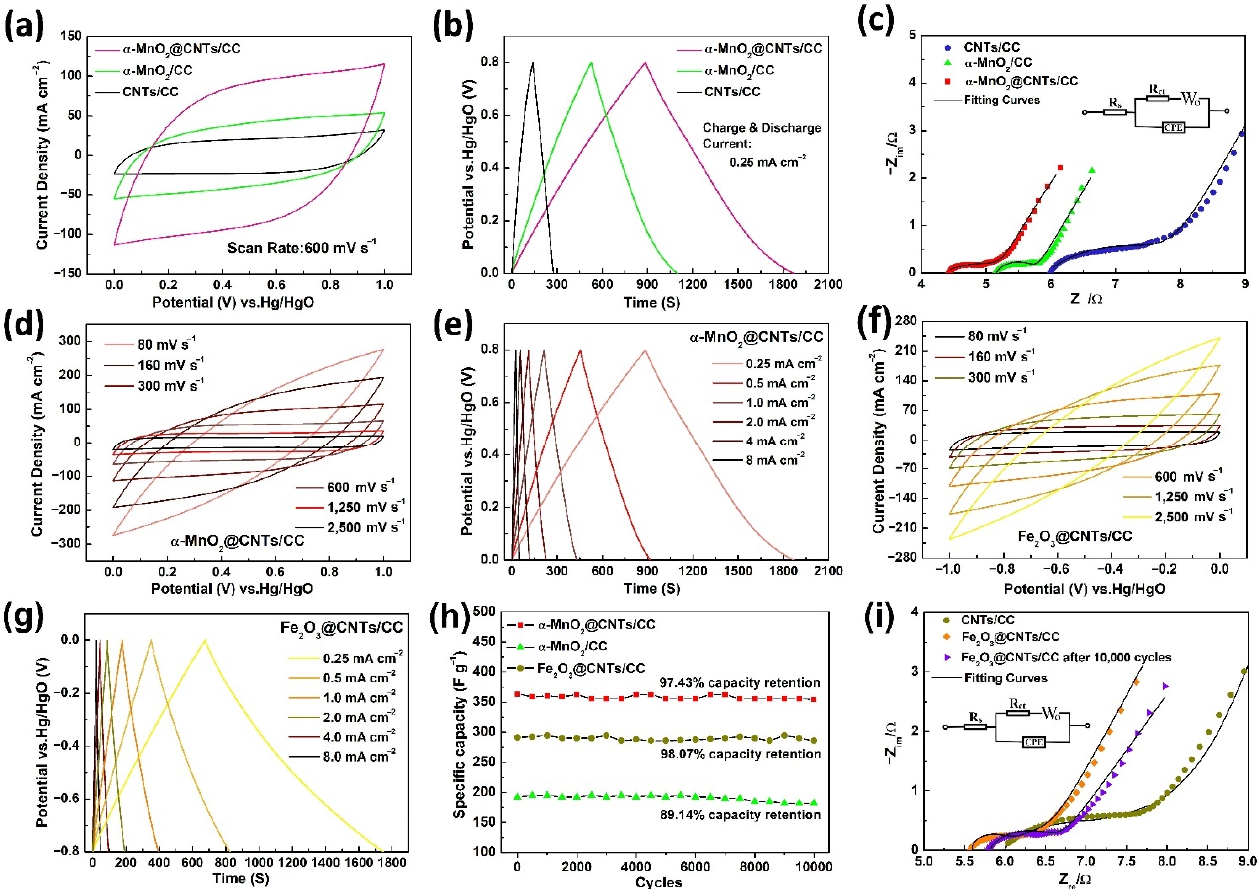
Figure 5. ( a ) CV curves, ( b ) GCD curves, and ( c ) Nyquist plots of CNTs/CC, α -MnO 2 /CC, and α